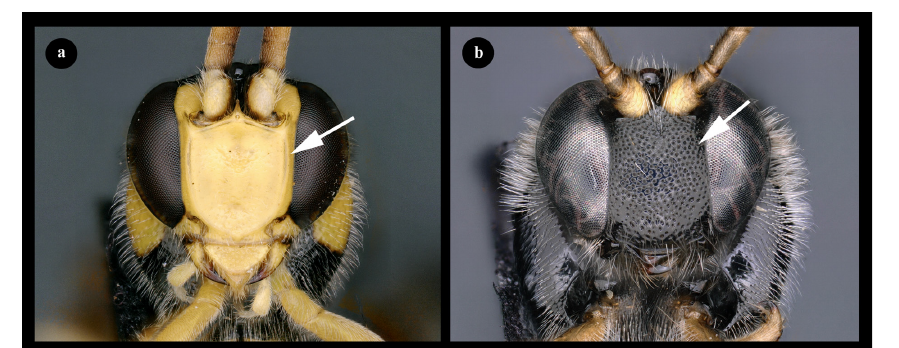
Fig. 1. a . Metopius sp., head, anterior view. b . Triclistus sp., head, anterior view. Arrow in Fig. 1a points to raised carina delineating shield-shaped area (compared to lack of carina in Fig. 1b).